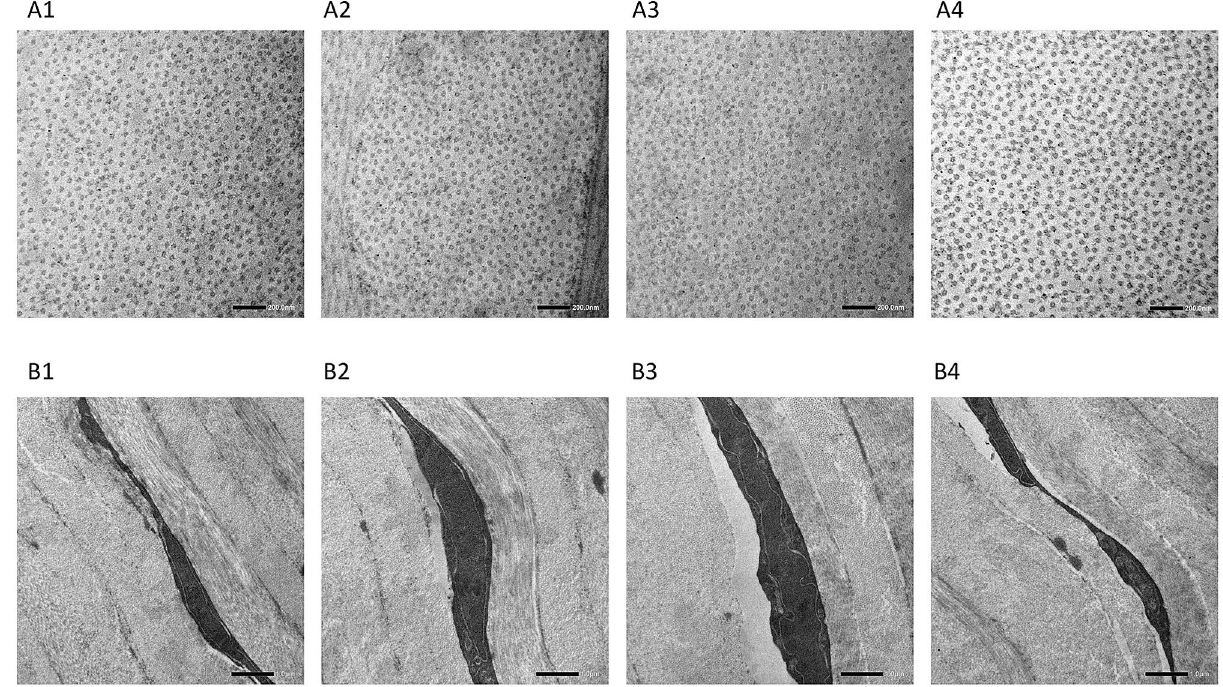
Figure 10. Transmission electron micrographs of the corneas showing transverse section of collagen fibrils ( A , scale bar 200 nm) and keratocytes ( B , scale bar 1 μm) for the control , 1 h , 4 h and 1 week after 4 h-exposure groups (A1–4 and B1–4, respectively).